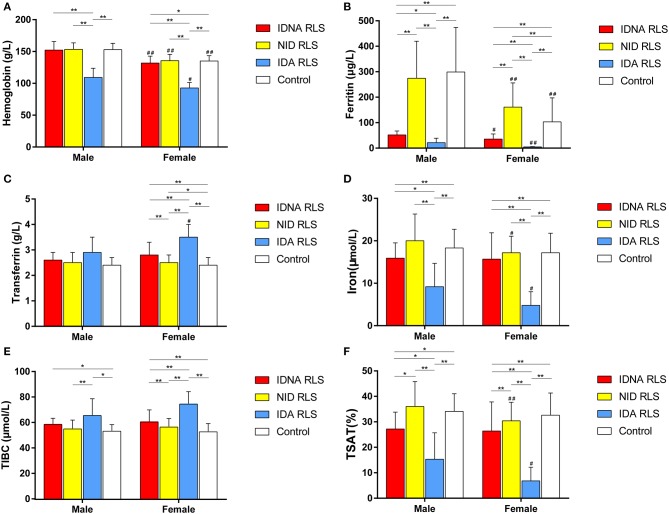
The hematologic and iron parameters by group and gender (A) Hemoglobin. (B) Ferritin. (C) Transferrin. (D) Iron. (E) TIBC. (F) TSAT. **P < 0.01, *P < 0.05, Kruskal-Wallis test and post-hoc Mann-Whitney test. Data compared between IDNA RLS (n = 83), NID RLS (n = 113), IDA RLS (n = 26), and controls (n = 63). ##P < 0.01, #P < 0.05, Mann-Whitney U-test. Data compared between male and female in each group of IDNA RLS, NID RLS, IDA RLS, and controls. Iron deficiency was defined as ferritin level <75 μg/L, or ferritin 75 μg/L, however TSAT <20%. IDA, Iron deficiency anemia; IDNA, Iron deficiency without anemia; NID, non-iron deficient; RLS, restless legs syndrome; TIBC, total iron-binding capacity; TSAT, transferrin saturation.